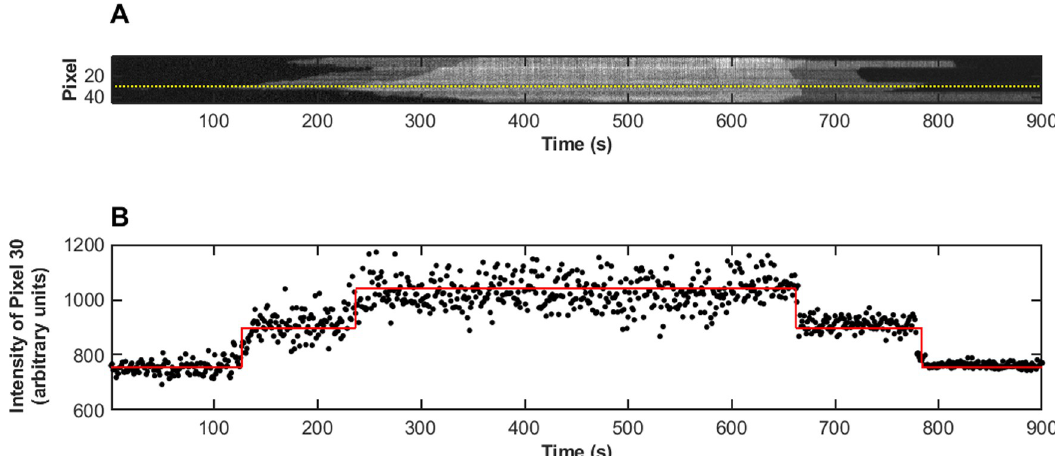
Fig 4. Two distinct Tpm1.1 intensity levels on an actin filament. (A) Kymograph, with pixel 30 indicated by the dotted line, and (B) intensity profile at pixel 30 of the filament shown in Fig 3D. The red line shows the fit to the intensity profile of pixel 30 of a function with identical magnitude intensity transitions. The transition magnitudes were found to be consistent across all the pixels in the kymograph. The fit optimised both the magnitude and the timing, with the results showing the transitions aligned with the single and double bound